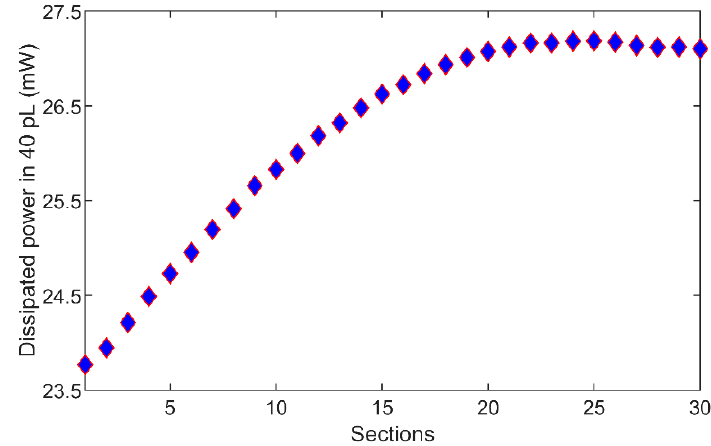
Figure 3. Dissipated microwave power in 30 water sections having a volume of 40 pL. Average dissipated power in 40 pL volumes is 26.19 mW for 1 W of input power, while standard deviation is 1.11 mW, which is 4.23% of the average value